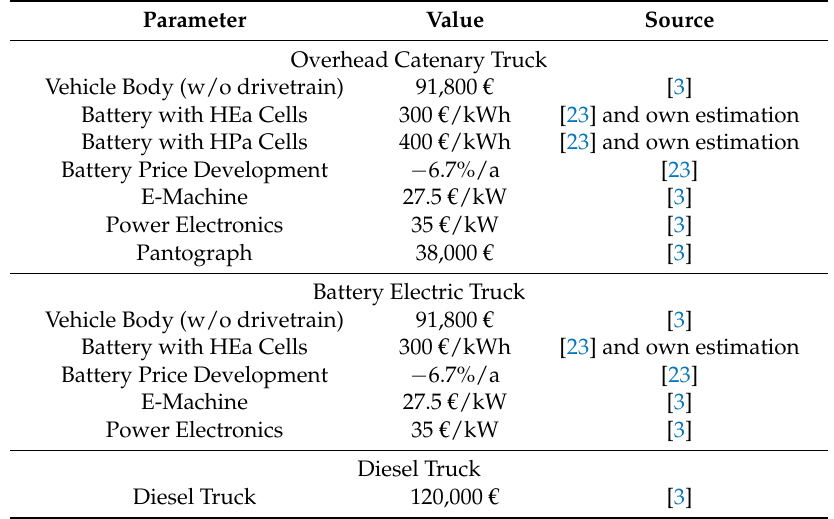
Table A1. Cost parameters for overhead catenary trucks, battery trucks, and diesel trucks.